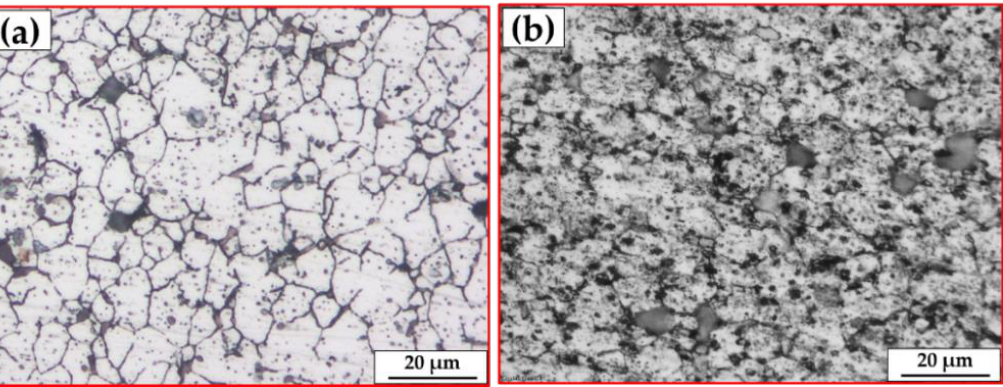
Figure 9. The macrostructures of the ( a ) AA2011-T6 AMP; ( b ) AA2011-T6 AMCP; ( c ) AA2011-O AMP; ( d ) AA2011-O AMCP produced at a rotation speed of 800 rpm and a 5 mm/min feed rate.